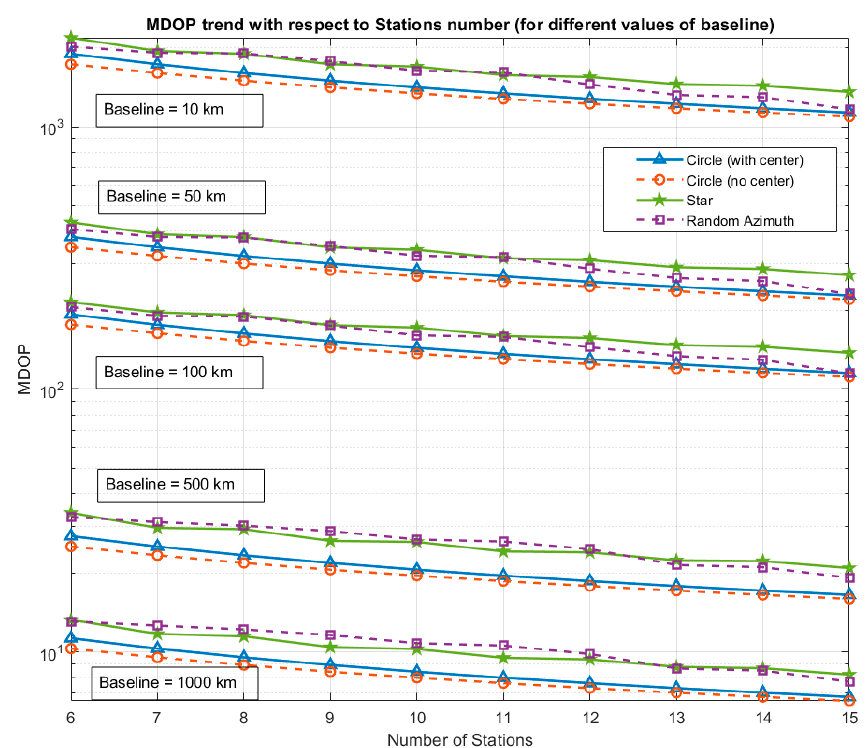
Figure 8. Logarithmic plot of the MDOP versus the number of stations. The plot is presented for all the selected configurations and for different values of the baseline.